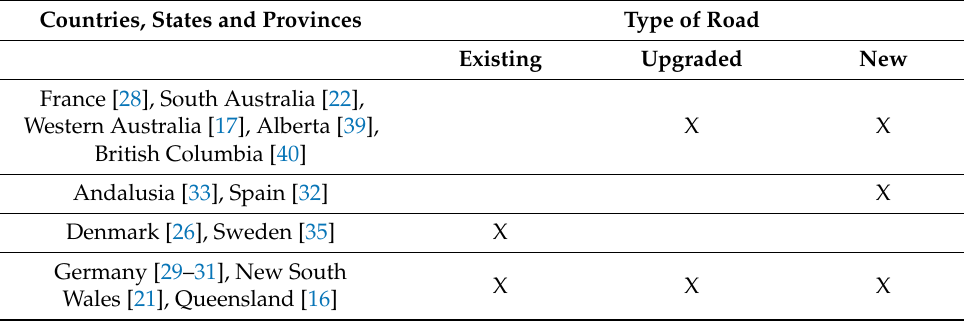
Table 7. Noise limits defined according to the type of road. Countries, States and